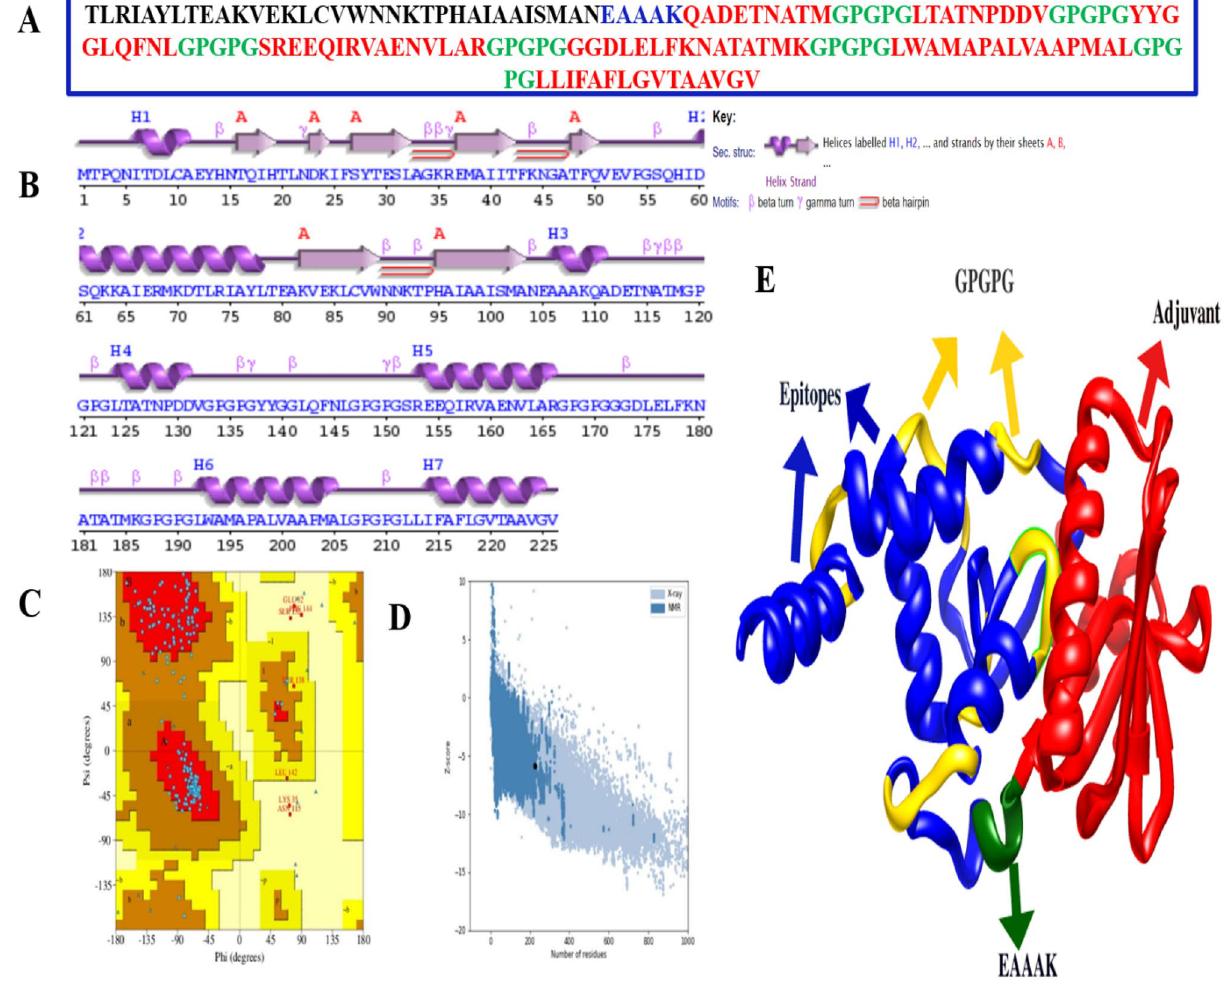
model ( C ), ProSA-web results showing Z-score of − 5.83( D ), Cartoon visualization of the designed vaccine 3D structure ( E